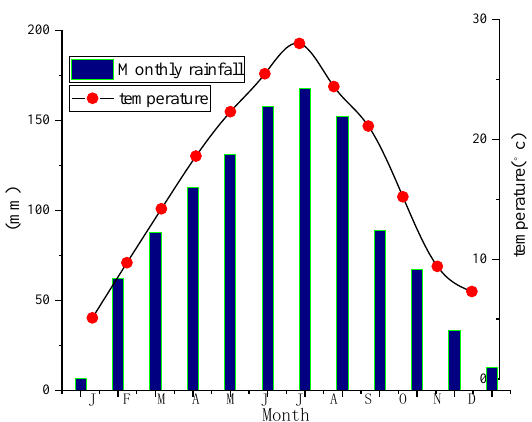
Figure 2. Rainfall and temperature distribution in the Yingshan County.